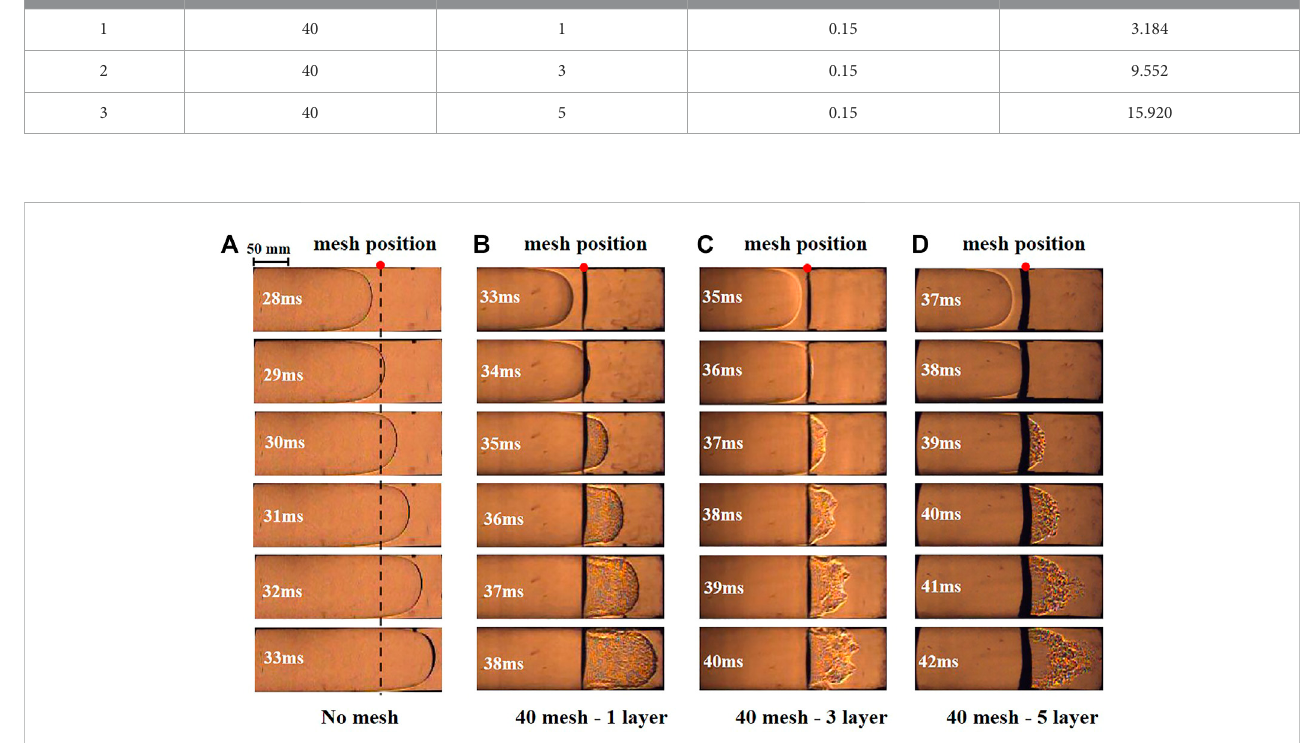
FIGURE 4 Microstructure diagrams of methane-air explosion fl ame propagation. (A) No mesh, (B) 1 layer, (C) 3 layer, (D) 5 layer.